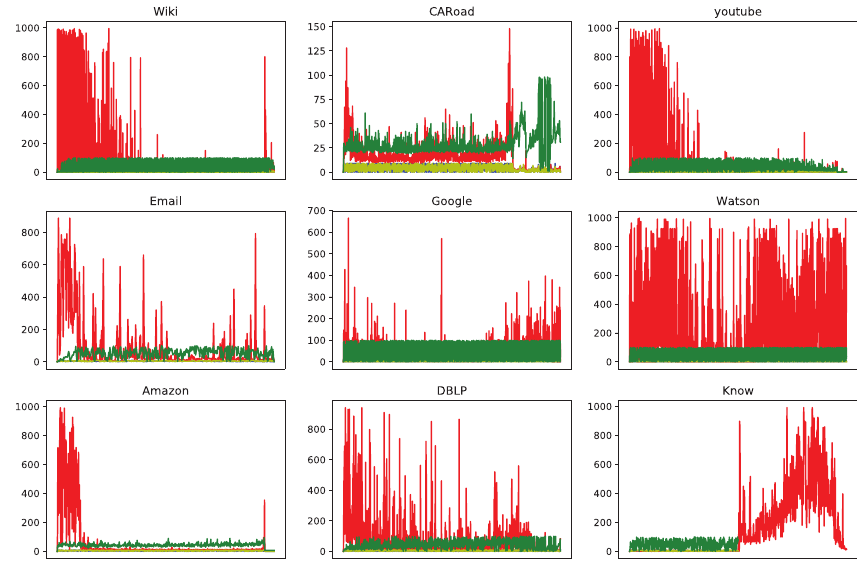
Figure 21. Entries’ consumption for each buffer. Blue, red, yellow and green lines refer to VEB, EB, VSB and PB,